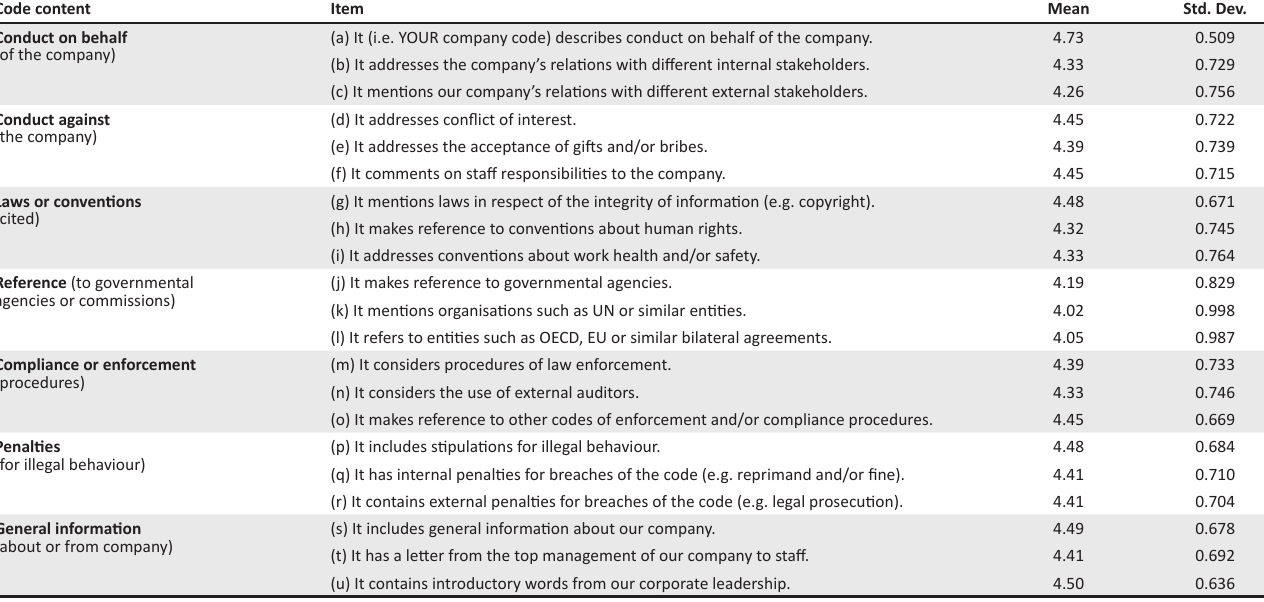
TABLE 1: Scale items and univariate descriptives. Code